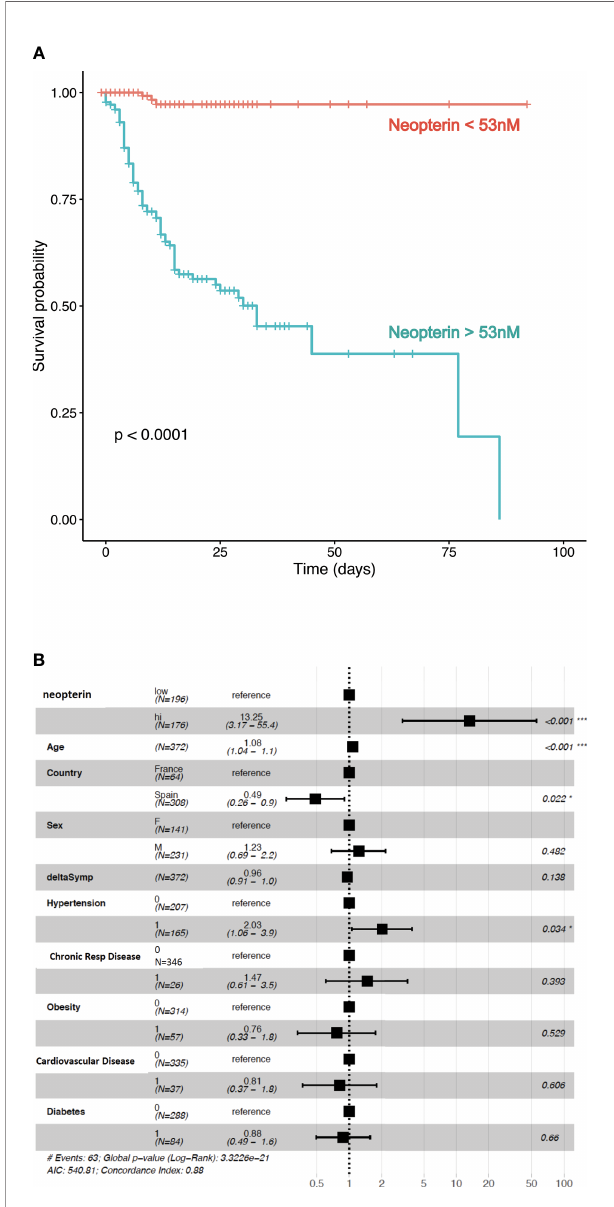
FIGURE 3 | Neopterin is a biomarker of fatal outcome in SARS-CoV-2 infected patients. (A) Time from symptoms onset to discharge (or death) was examined in this multi-centric study. Survival curves for Covid-19 patients with high (>53nm) or low (<53nM) serum concentration of neopterin at hospital admission. Kaplan-Meier estimator graph with log-rank based statistics. (B) Cox proportional hazard model was used to analyze the effect of confounders, such as age, sex, country, diabetes, obesity, hypertension, respiratory disease and cardiovascular disease. Proportional hazard ratios are indicated along with their 95% con fi dence